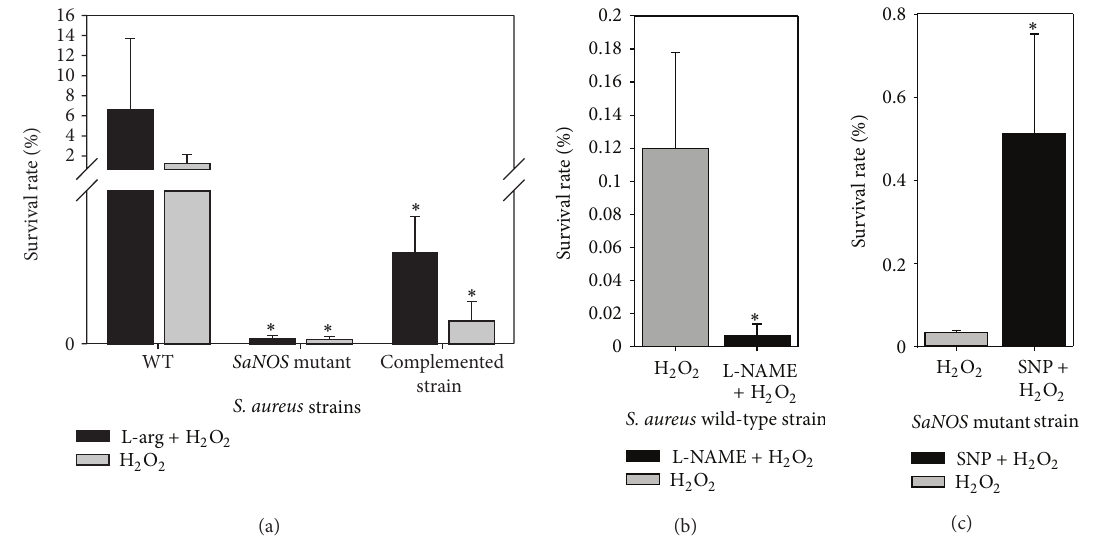
Figure 2: (a) Survival of S. aureus SH1000, its isogenic SaNOS mutant, and the mutant complemented with SaNOS gene in trans from a lethal dose (350mM) of H 2 O 2 with and without supplementation with 1mM L-arginine. (b) Survival of wild-type S. aureus SH1000 pretreated with 5mM L-NAME from 350 mMH 2 O 2 . (c) Survival of SaNOS mutant of S. aureus SH1000 pre-treated with 2.5 mMsodium nitroprusside from 350 mMH 2 O 2 . ∗ Significant at 𝑃 < 0.05